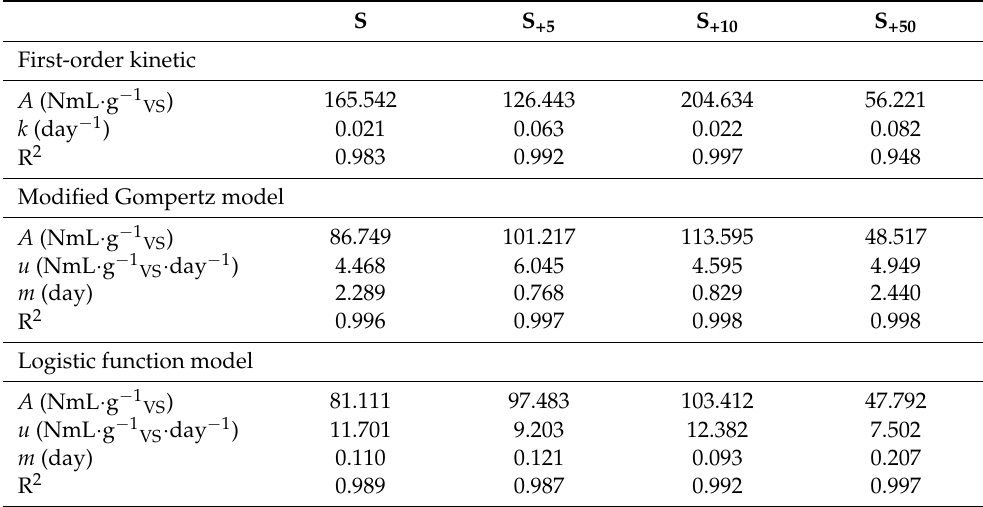
Table 4. Estimated kinetic parameters for the three kinetic models (first order, modified Gompertz, logistic